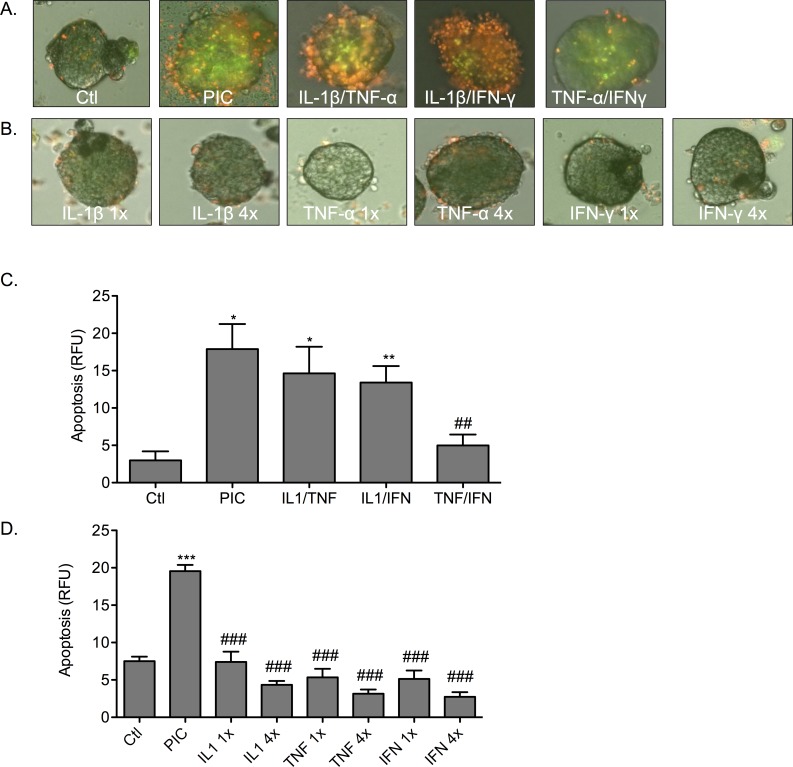
Single cytokine treatment is not sufficient to induce apoptosis in isolated mouse islets.Islets were examined microscopically following labeling with YO-PRO-1 (green) and propidium iodide (red). (A) Islets were treated with a triple cytokine cocktail of IL-1β/TNF-α/IFN-γ (PIC), or dual cytokine combinations of IL-1β/TNF-α, IL-1β/IFN-γ, or TNF-α/IFN-γ. (B) Islets were treated with a single cytokine of either IL-1β, TNF-α, or IFN-γ at a 1-fold (1x) or 4-fold (4x) dose. Graph shows quantified apoptosis (C) from dual cytokine treatment or (D) from single cytokine treatment for 1x and 4x doses for all islets per experiment * p < 0.05, ** p < 0.01, *** p < 0.001 relative to Ctl, ## p < 0.01, ### p < 0.001 relative to PIC and n = 3.